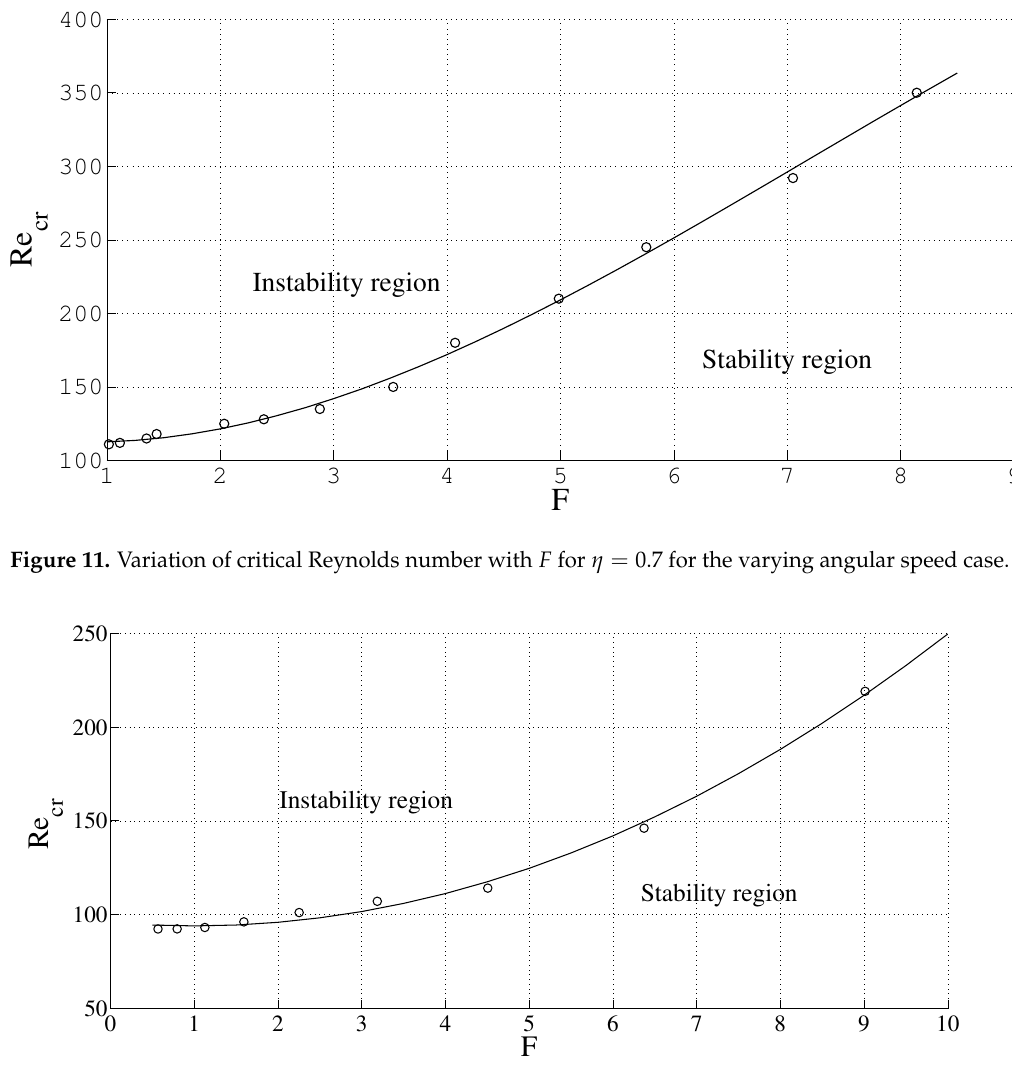
Figure 12. Variation of critical Reynolds number with F for η = 0.4 for the varying angular speed